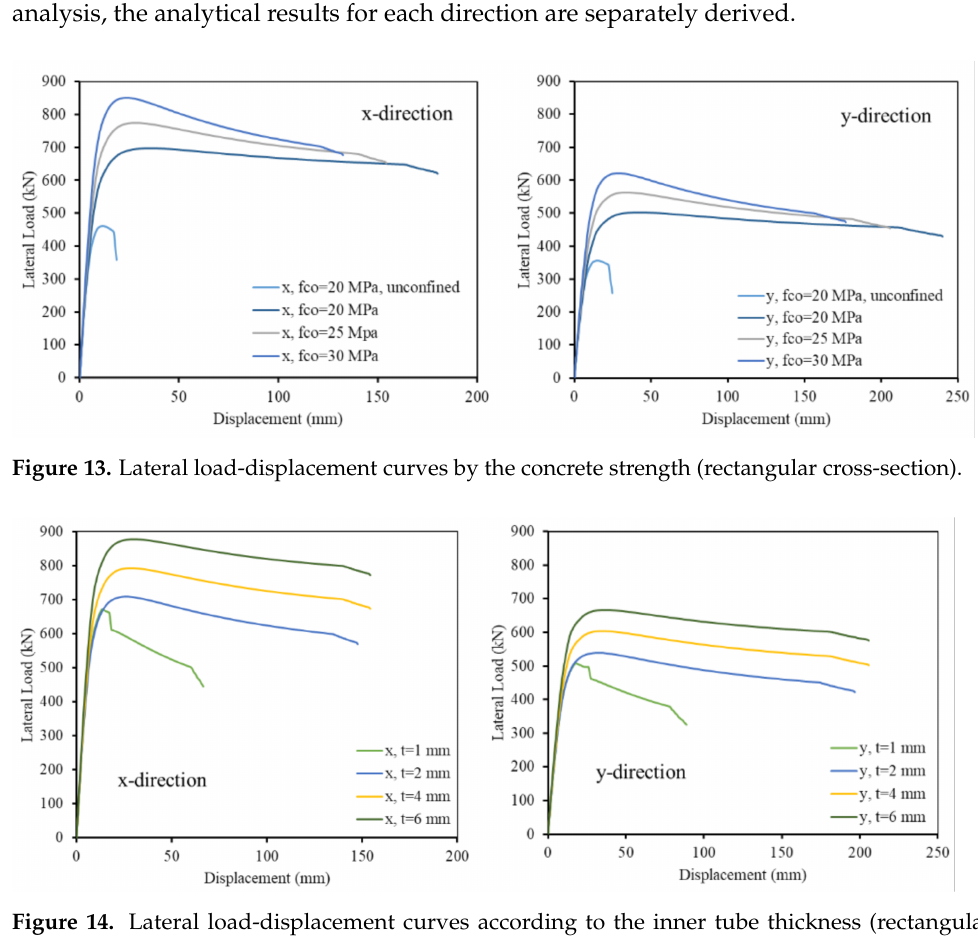
Figure 14. Lateral load-displacement curves according to the inner tube thickness (rectangular